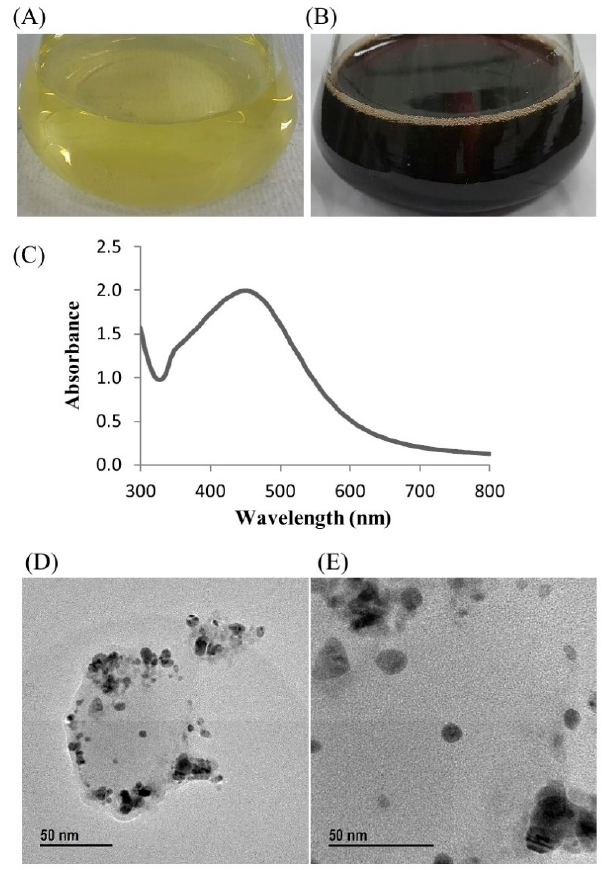
Figure 2. R2A broth with AgNO 3 as control ( A ), synthesized silver nanoparticles (AgNPs) ( B ), UV–vis spectra ( C ) and field emission–transmission electron microscopy (FE–TEM) images of synthesized silver nanoparticles ( D , E ).